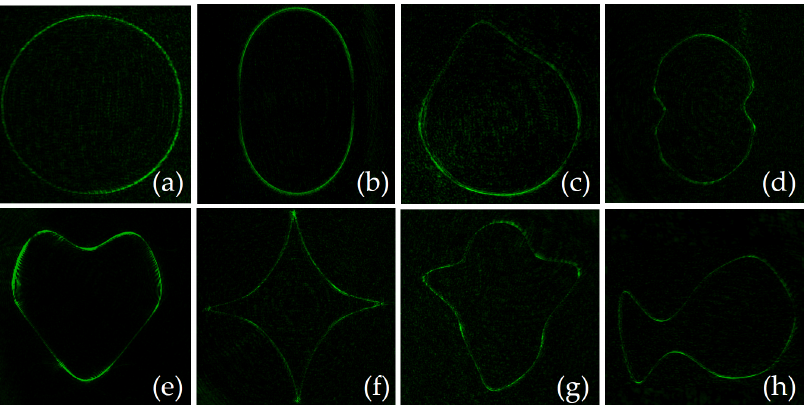
Figure 5. Intensity of the light beams designed by estimating the parametric equations of the shapes shown in Figure 4; ( a ) ring, ( b ) ellipse, ( c ) droplet, ( d ) nephroid, ( e ) heart, ( f ) astroid, ( g ) ghost, and ( h )